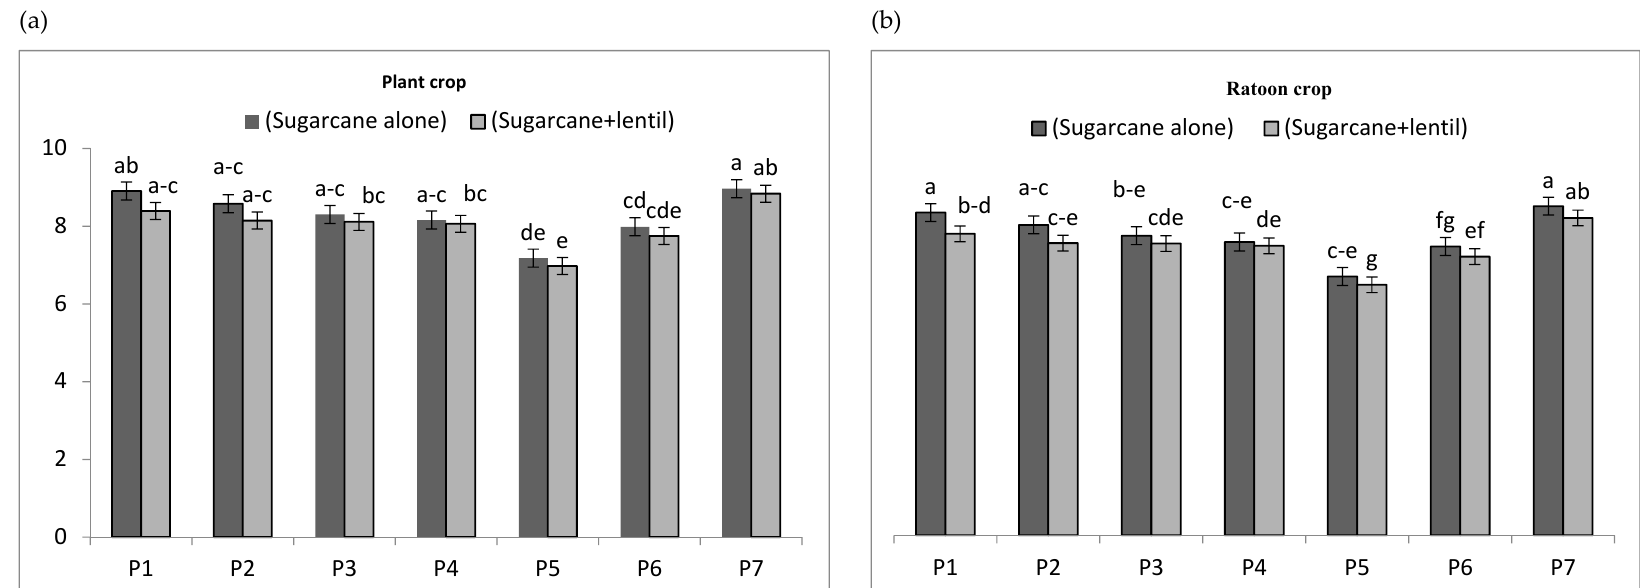
Figure 3. Leaf area index of sugarcane as influenced by various planting patterns and lentil intercropping in (a) Plant crop and (b) ratoon crop. P 1 : 45 cm pits with 90 cm diameter, P 2 : 60 cm pits with 90 cm diameter, P 3 : 75 cm pits with 90 cm diameter, P 4 : 90 cm pits with 90 cm diameter, P 5 : 60 cm single rows planting, P 6 : 90 cm double rows planting, P 7 : Trench planting at 120 cm. Any two means not sharing a common letter(s) differ significantly at 5% probability.